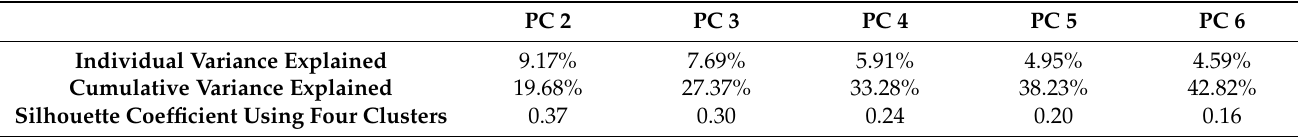
Figure 4. Scatterplot of the first two PC loading vectors for Lake Michigan ( left ) and Lake Superior ( right ). Figure 4 . Scatterplot of the first two PC loading vectors for Lake Michigan (left) and Lake Superior (right). Table 1. Variance explained for each of the PCs 2 through 6 and silhouette coefficients while using four clusters for Lake Michigan.